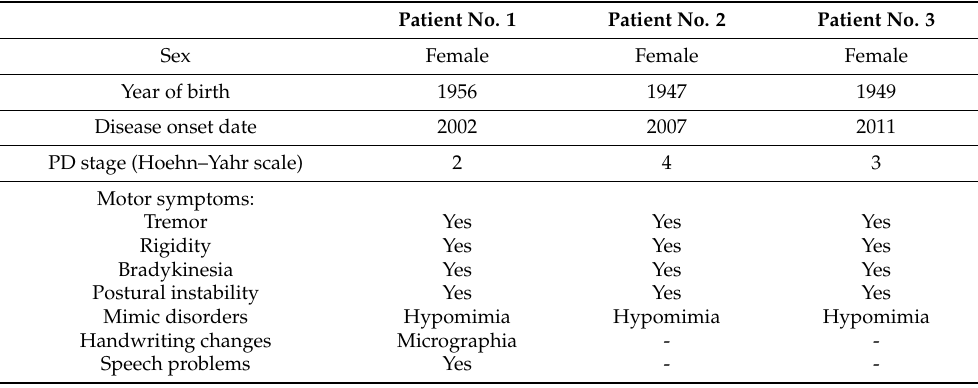
Table 1. Characteristics of twins with